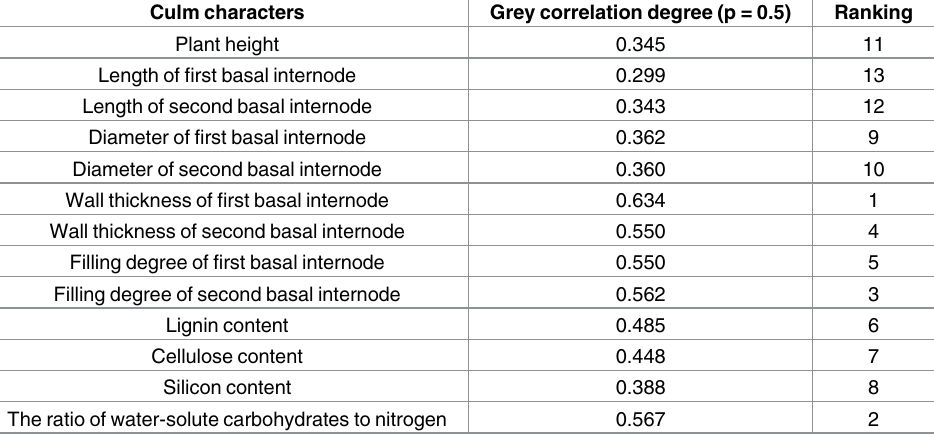
Table 7. Grey relational analysis for culm lodging resistance index and culm